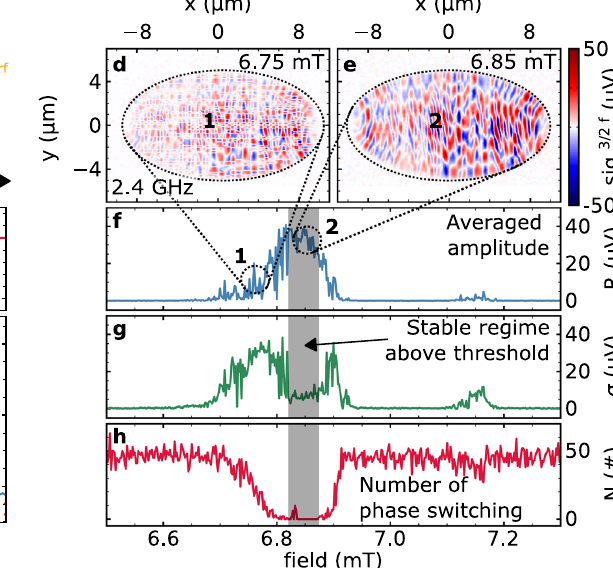
outputbacktotheinitiallevel.Switchingeventsaredepictedbygreendots.Panels d and e show two spatially-resolved measurements of a 20 μ m×10 μ m elliptical element at slightly different fi eld values revealing different regions of stability. f , g , and h Field-dependent measurements performed in the center of the ellipse where the signal is detected for 50 s at each fi eld step resulting in an averaged amplitude R ,acorrespondingstandarddeviation σ andacounterforthenumberof phase switching events N,